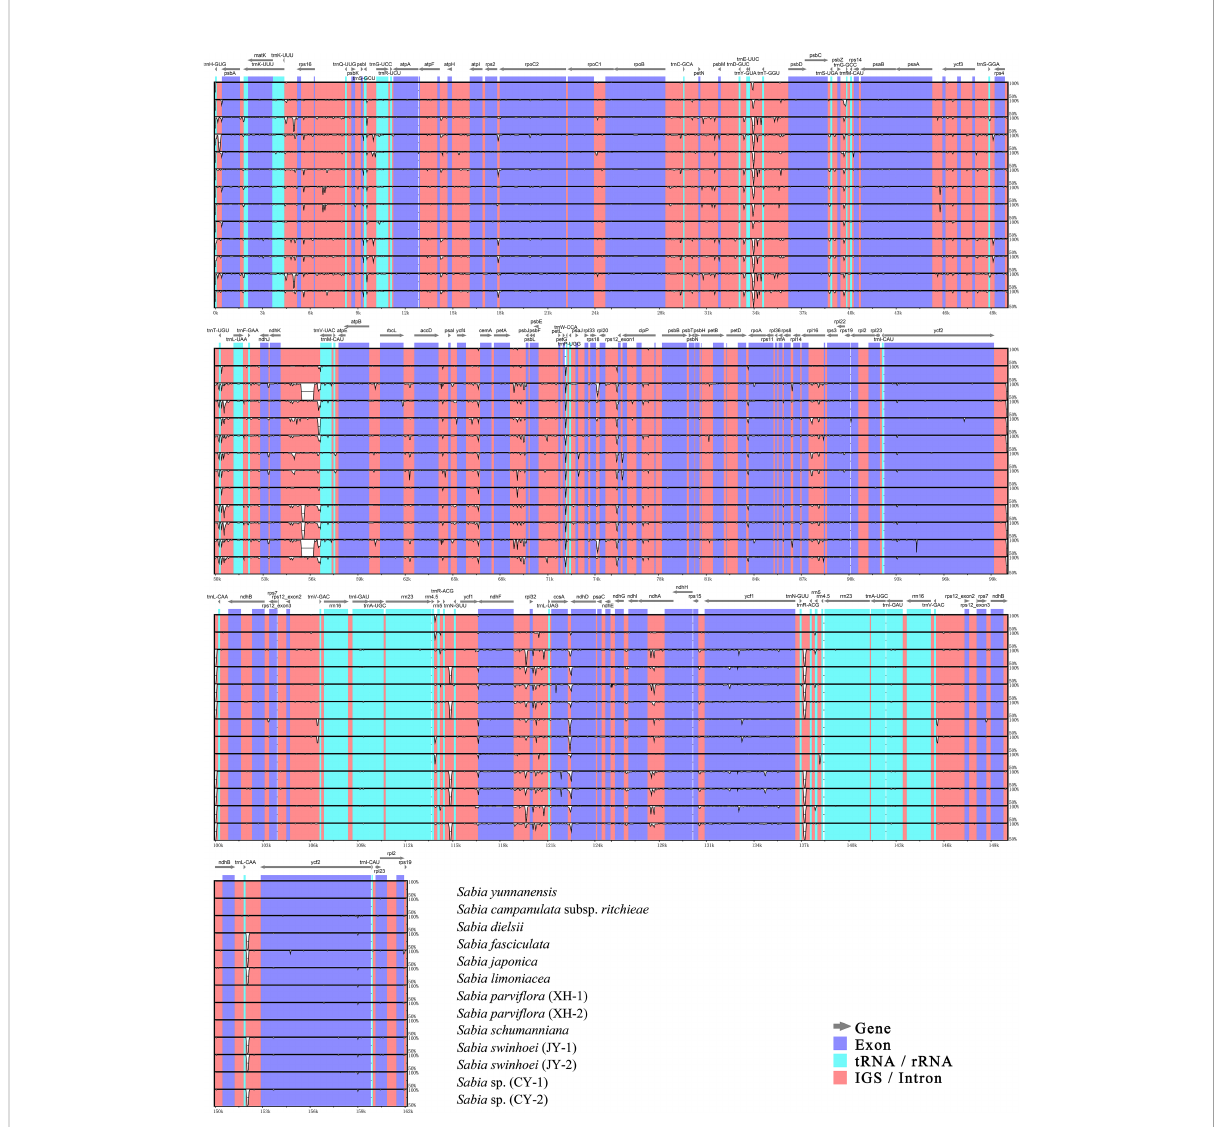
FIGURE 5 Complete chloroplast genome alignment of Sabia species with mVISTA. The vertical scale indicates the average percent identity, ranging from 50% to 100%. The horizontal scale indicates the coordinates within the chloroplast genome. Gray arrows above the alignment indicate genes with their